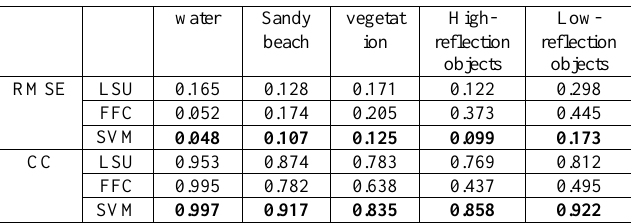
Figure 4. (a) Training pixels for LSU and SVM. (b) Training pixels for